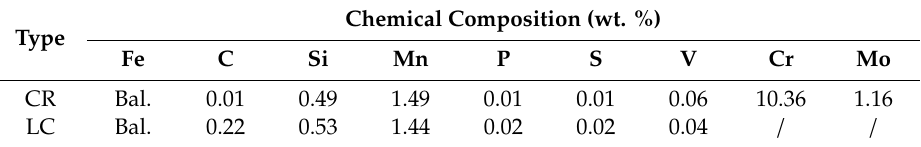
Table 1. Chemical compositions of corrosion-resistant (CR) and low-carbon (LC) steel.